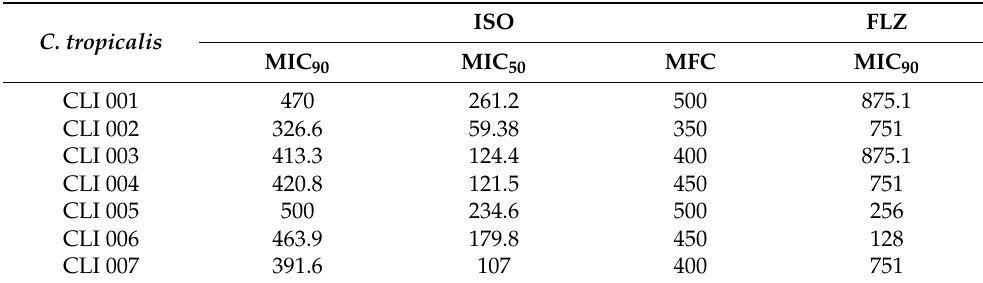
Figure 2. Growth reduction of C. tropicalis isolates exposed to ISO (MIC of each isolate). A strong and positive linear relationship between the ISO concentration and the yeast growth reduction percentage is observed, i.e., as the ISO concentration increases, the yeast growth reduction percentage also increases, which coincides with the Pearson correlation coefficient (0.83 < r < 0.96) in all isolates. In addition, the hypothesis test on the correlation coefficient yields a p -value < 0.05, which indicates that, with 95% confidence, there is a significant linear relationship. Table 1. Minimum inhibitory concentration (MIC) and minimum fungicidal concentration (MFC) values (µg/mL) of ISO and FLZ against C. tropicalis .